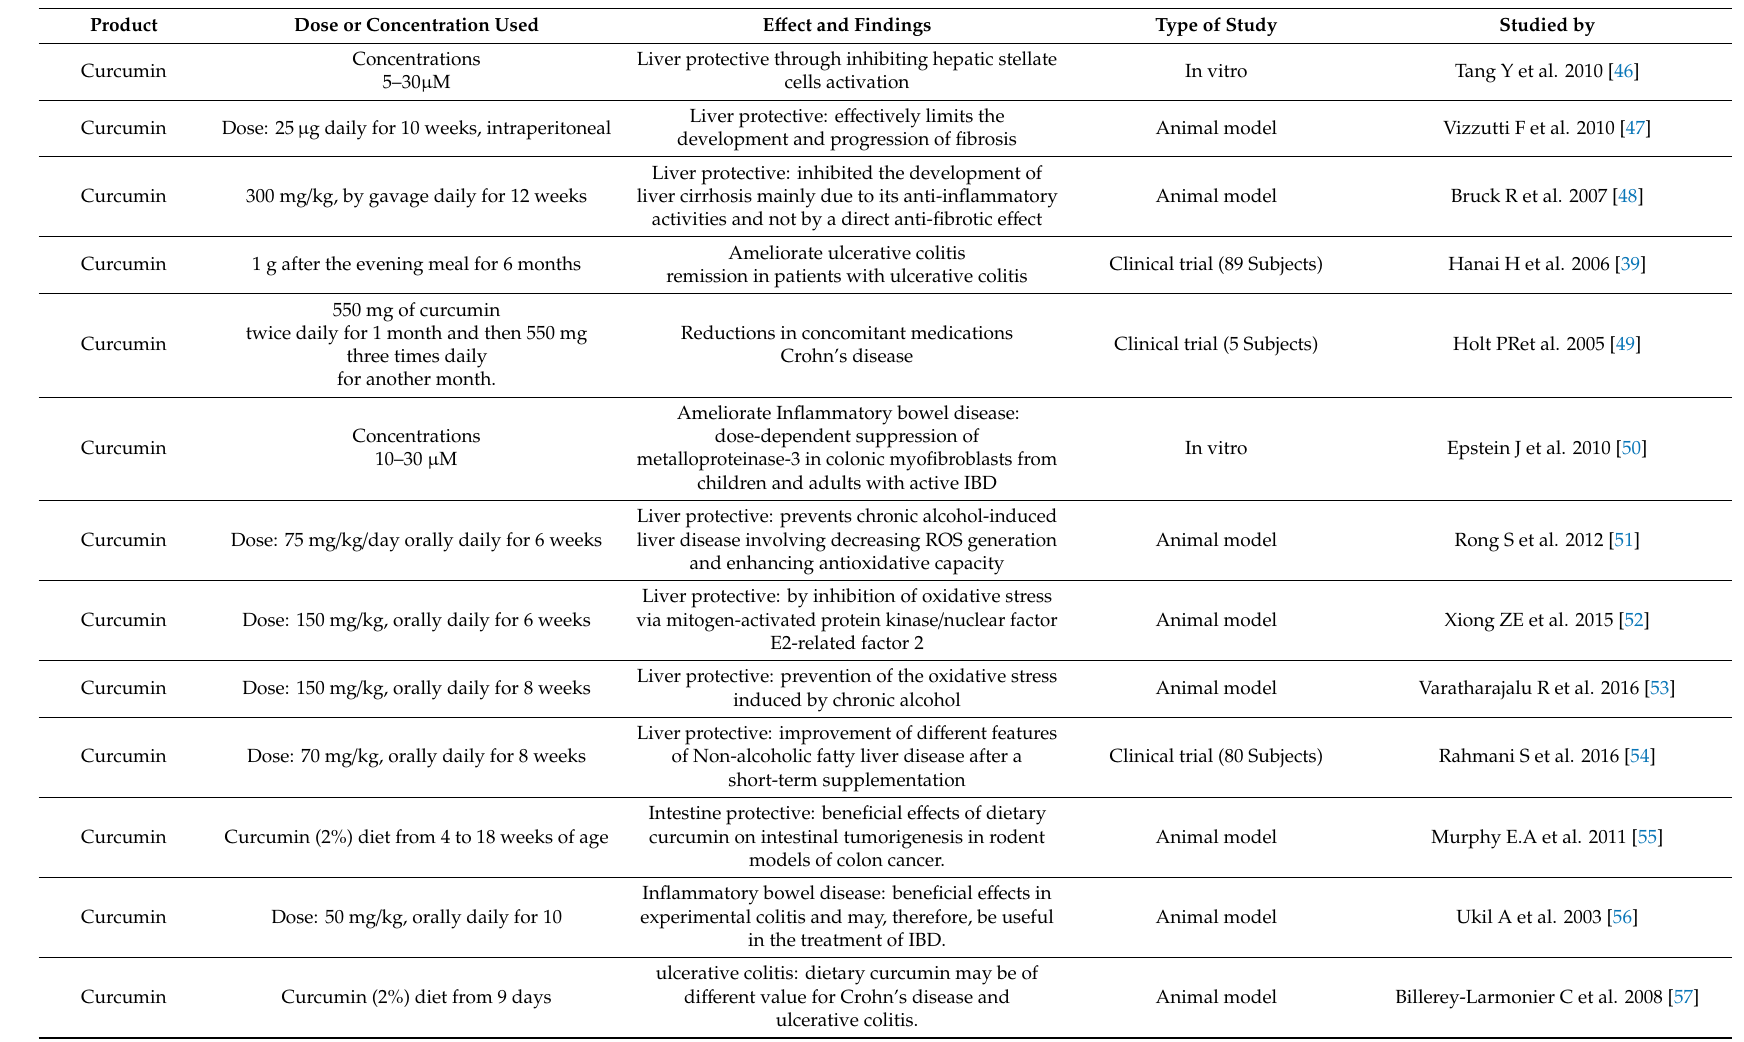
Table 2. Gastrointestinal E ff ect of